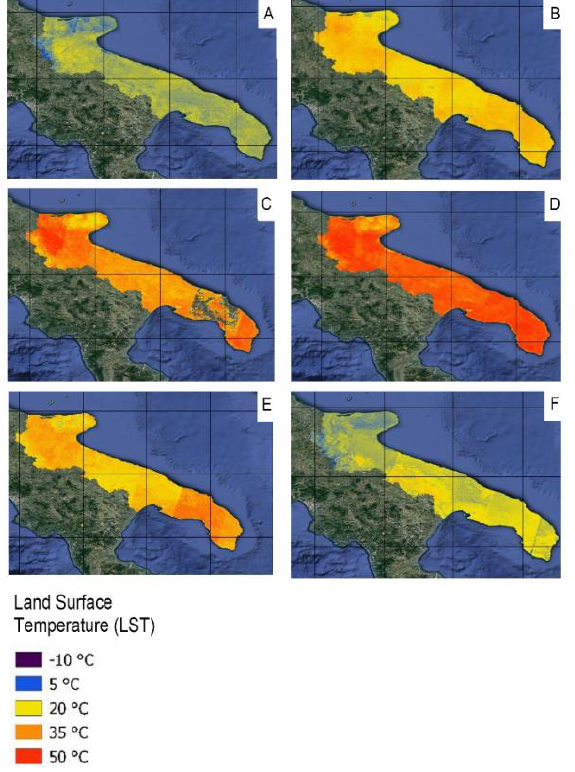
Fig. 1: Land Surface Temperature maps. A. January-February